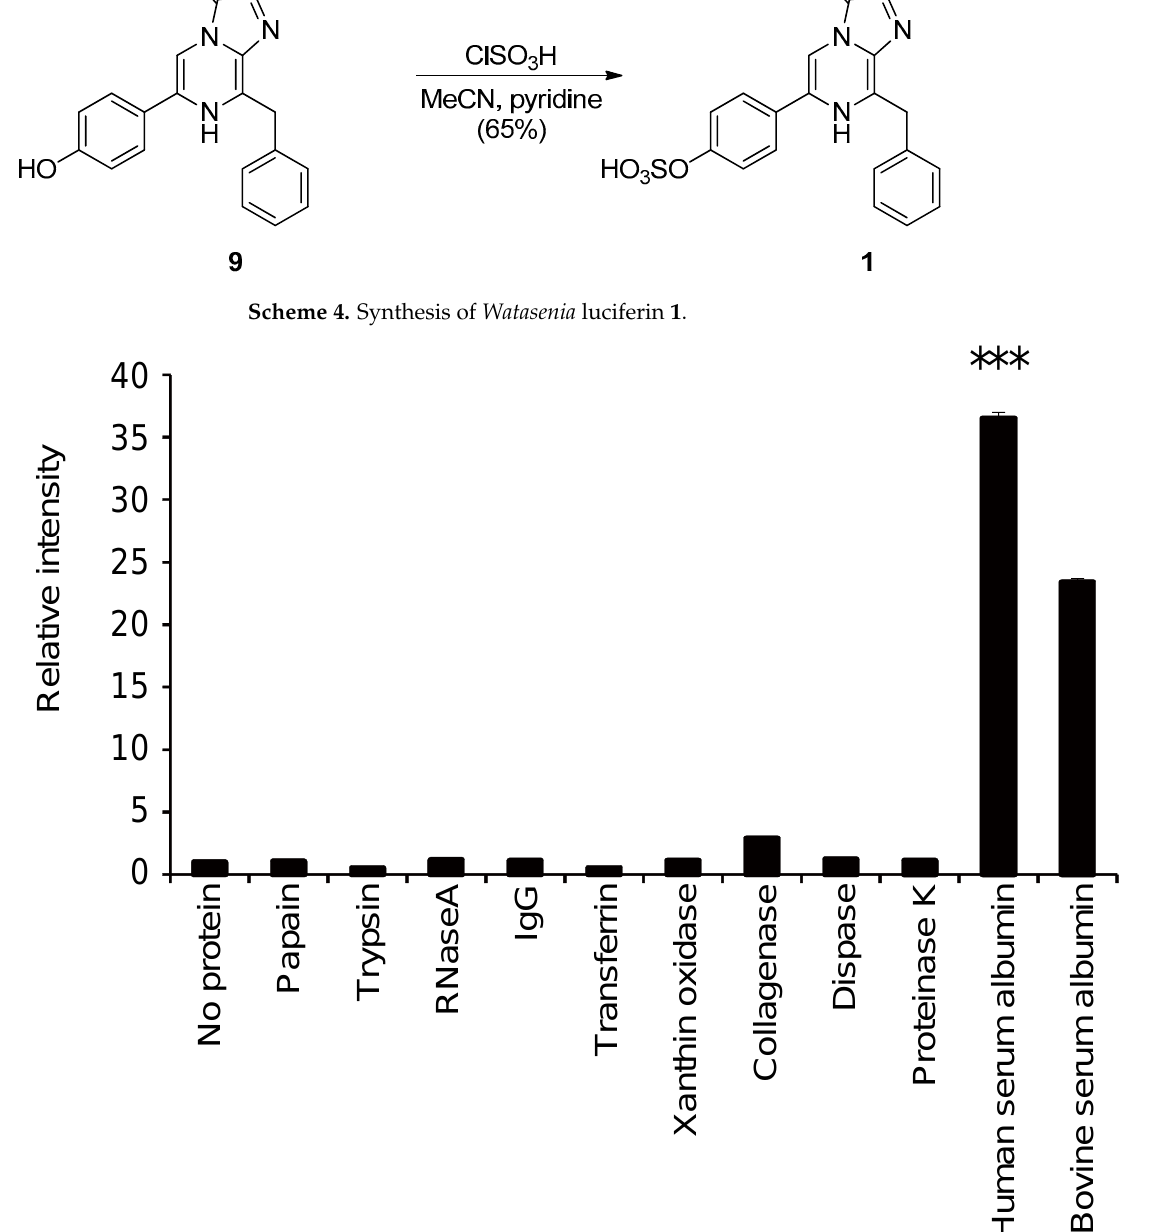
Figure 1. Relative luminescence intensity emitted by the reaction of each protein (1 mg/mL) (hori- zontal axis) with Watasenia luciferin. The values for each group were compared with human al- bumin values (mean ± SEM, n = 4; one-way ANOVA with Dunnett’s test, *** p < 0.001).